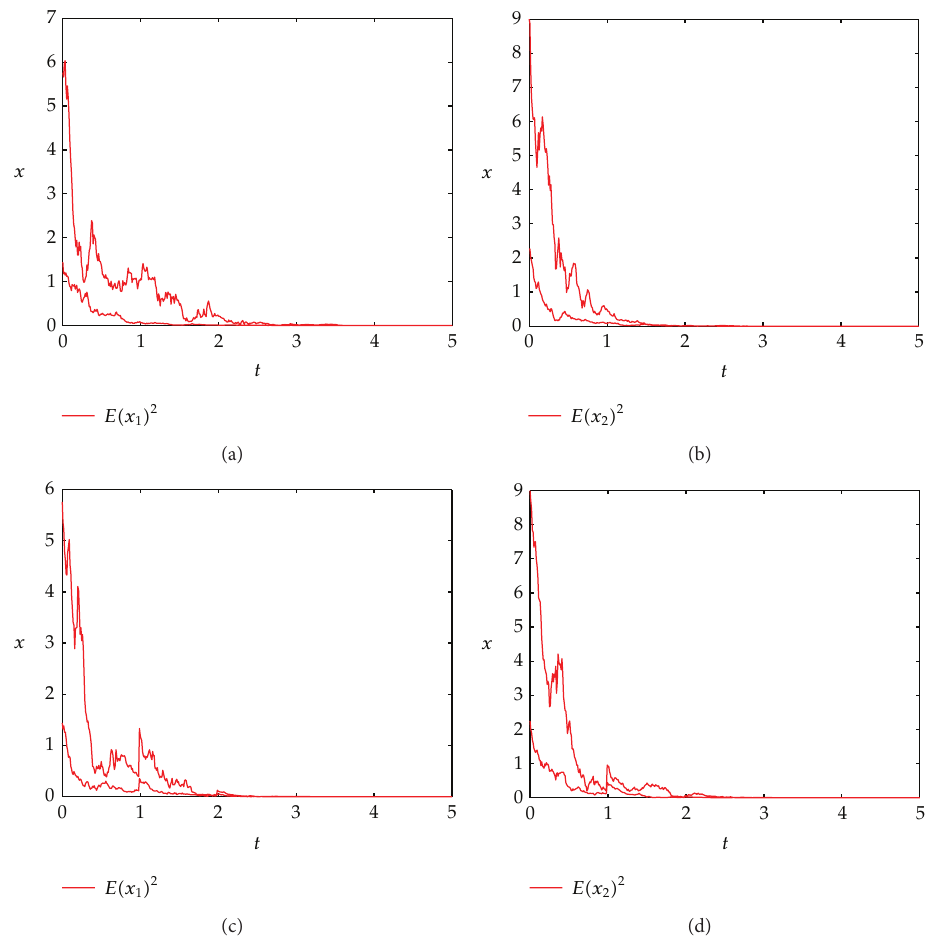
Figure 1: (a) Time-series of the 𝐸(𝑥 1 ) 2 of model (55) without impulsive effects for 𝑡 ∈ [0,5] . (b) Time-series of the 𝐸(𝑥 2 ) 2 of model (55) without impulsive effects for 𝑡 ∈ [0,5] . (c) Time-series of the 𝐸(𝑥 1 ) 2 of model (55) with impulsive effects for 𝑡 ∈ [0,5] . (d) Time-series of the ) 2 of model (55) with impulsive effects for 𝑡 ∈ [0,5] 𝐸(𝑥 2